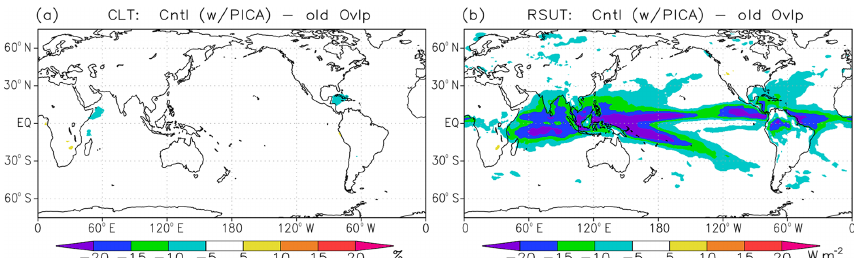
Figure 7. Impacts of new cloud overlap scheme, PICA, for shortwave radiation calculation on (a) total cloud cover (%) and (b) TOA upward shortwave radiative flux (Wm − 2 ). The plots show results for the control model (with PICA) minus those for an experiment with an old version of the cloud overlap scheme.